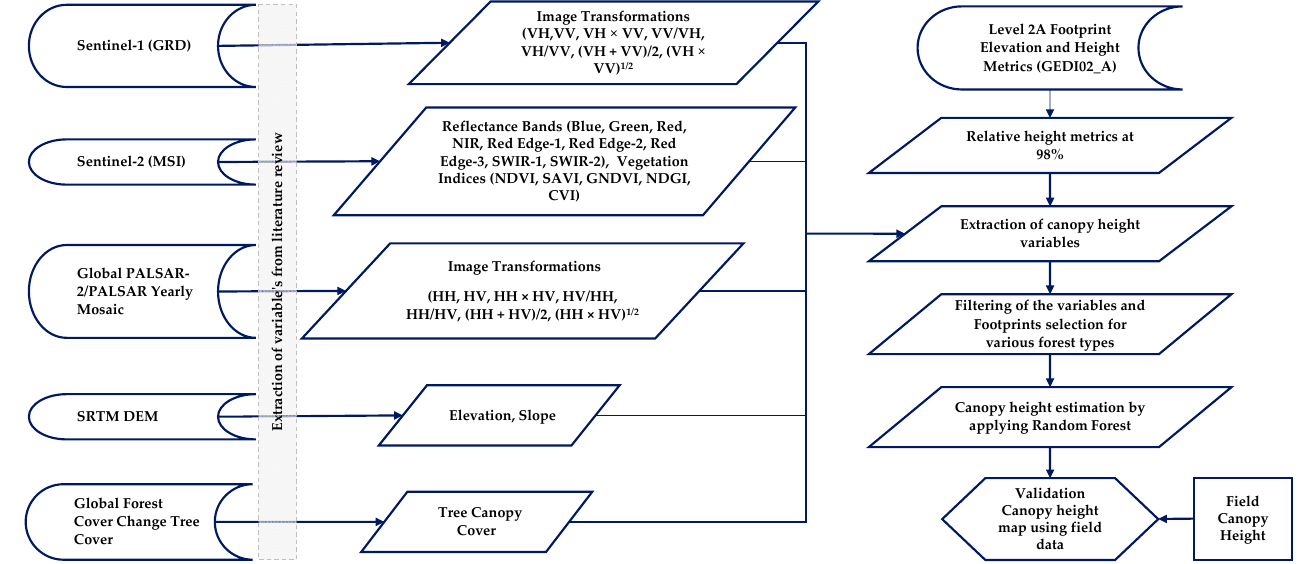
Figure 2. Methodological flow diagram for predicting the canopy height using the GEDI canopy height data by applying the decision tree-based machine learning (ML) algorithm.